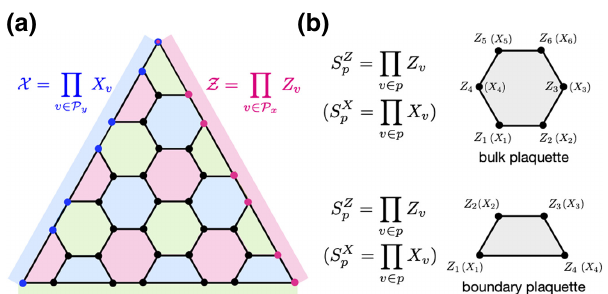
FIG. 8. The color code on the honeycomb lattice. (a) A trian- gular patch of the color code on the honeycomb lattice. Plaque- ttes appear in three colors, i.e., blue, green, and red. The logical operators Z and X are given by products of Z (cid:2) and X (cid:2) along boundary paths P x and P y , respectively. (b) The generators of (cid:5) (cid:5) = = X the stabilizer group S Z v ∈ p Z v and S v ∈ p X v , each con- p p sisting of six (four) Z ( X ) operators acting on the qubits of each hexagon in the bulk (on the boundary) independent from its